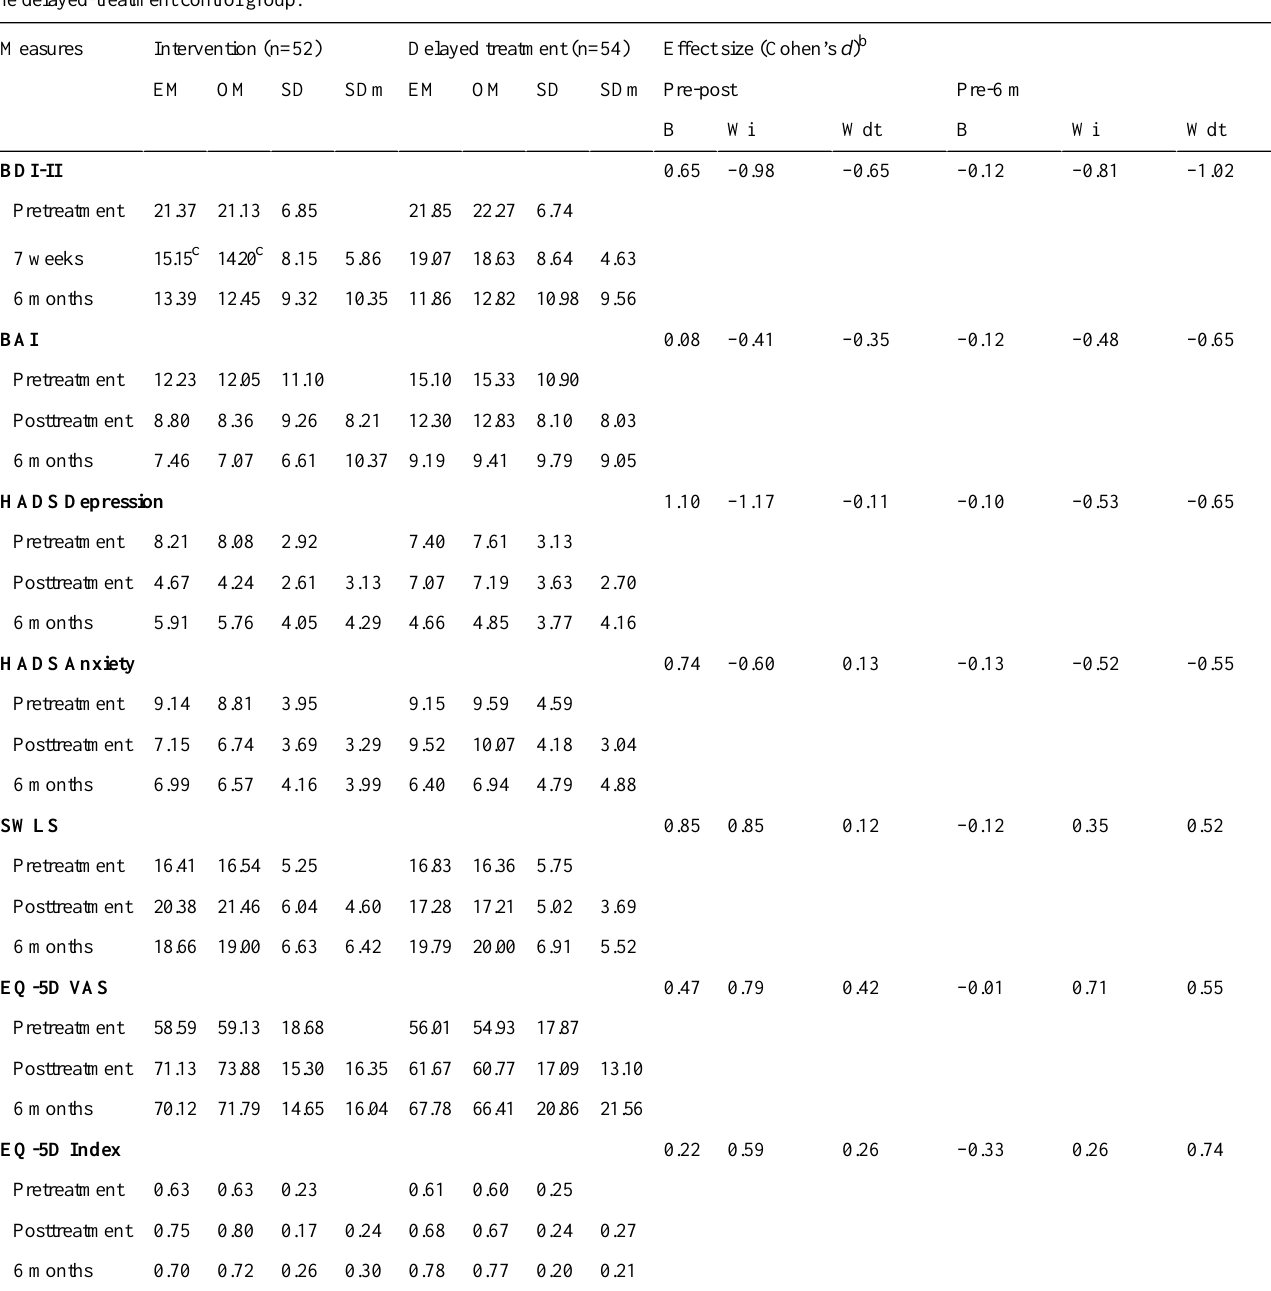
Table 2. Estimated means (EM), a observed means (OM), observed standard deviations (SD), standard deviations based on linear mixed-models variance estimates (SDm), and effect sizes from pretreatment (pre) to posttreatment (post) and pretreatment to 6-month follow-up (6 m) for the intervention and the delayed-treatment control